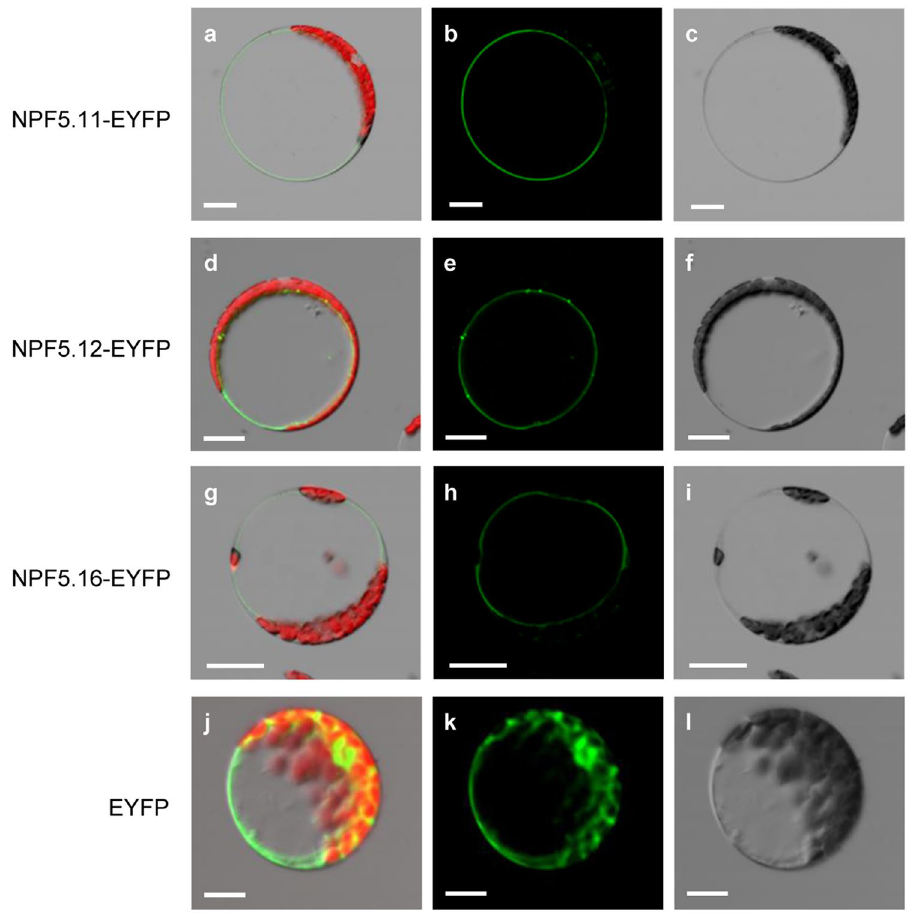
Figure 1. Subcellular localization of NPF5.11, NPF5.12 and NPF5.16. NPF5.11-EYFP ( a – c ), NPF5.12-EYFP ( d – f ), NPF5.16-EYFP ( g – i ) or EYFP ( j – l ) was driven by the cauliflower mosaic virus 35 S promoter and transiently expressed in Arabidopsis mesophyll protoplasts. Overlap images of EYFP (green) and chlorophyll (red) fluorescence ( a , d , g , j ), EYFP fluorescence ( b , e , h , k ), and bright-field ( c , f , i , l ) images are shown. Bars = 20 μ